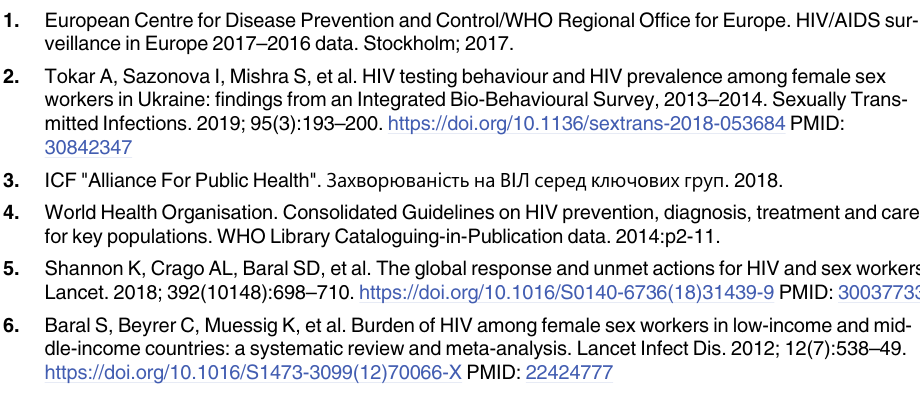
S4 Table. Independent variables from IBBS and corresponding thematic clusters for 2009, 2011, 2013, 2015 and 2017. S5 Table. Barriers and facilitators to accessing HIV prevention stratified by receipt or non-receipt of extended PP between 2009 and